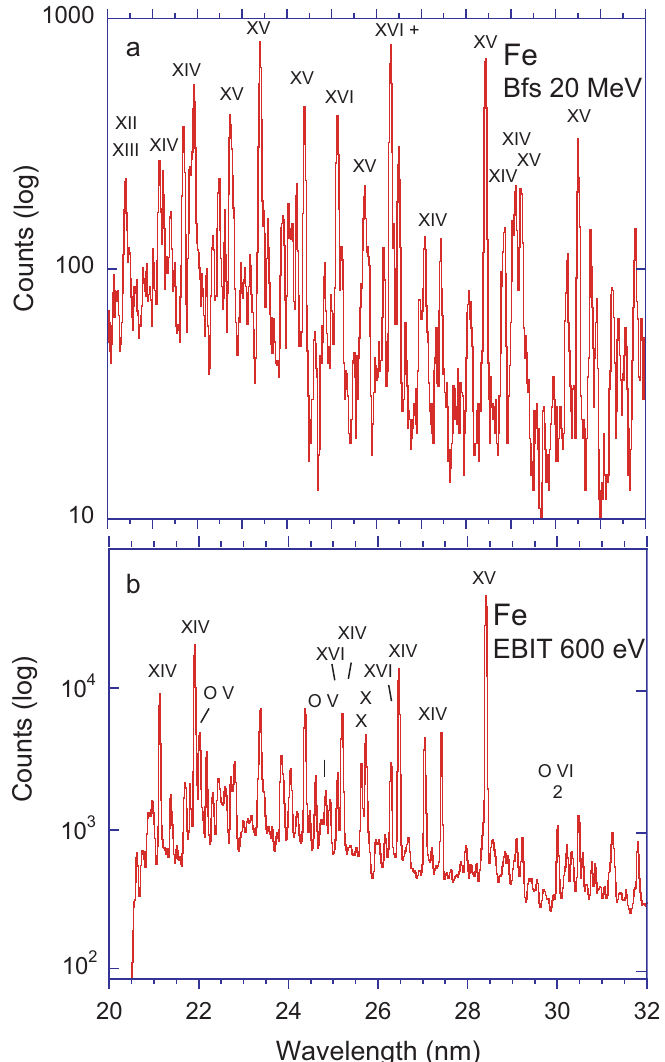
Figure 14. Fe spectra observed with ( a ) the beam–foil light source [104] and ( b ) in an electron beam ion trap (see [28,29]). The beam–foil spectrum of Fe has been recorded at an ion beam energy of 20 MeV. Slit width 80 µ m, line width (FWHM) 0.06 nm. The charge state distribution is centered on q = 11 + , and ion charge states q = 8 + to q = 14 + are expected to contribute. The EBIT spectrum has been obtained at an electron beam energy of 600 eV. The strongest lines are identified by the spectrum number. Line labels including an Arabic numeral ‘2’ indicate a line in second diffraction order; several O V and O VI lines appear and serve for wavelength